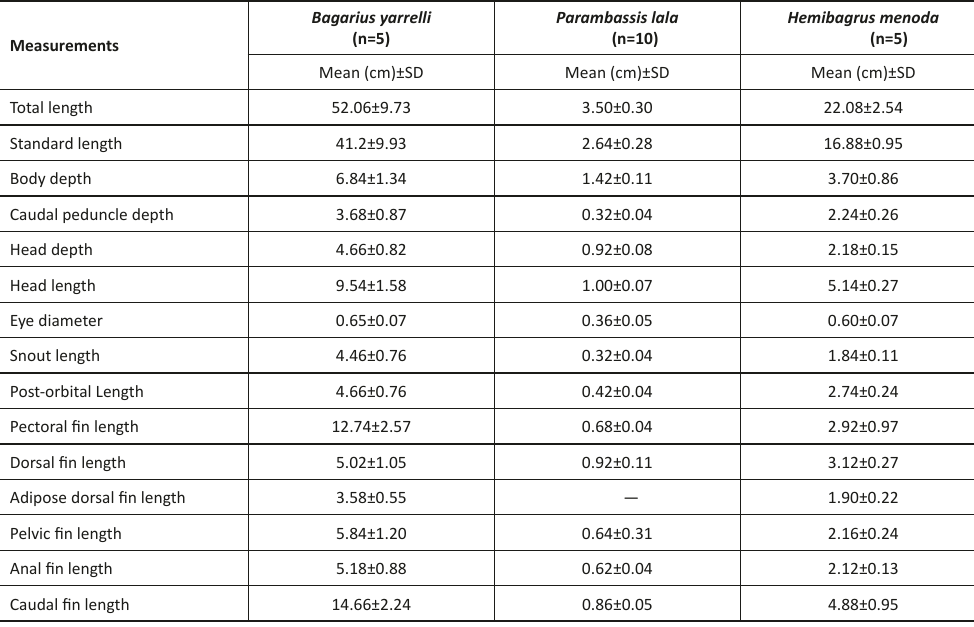
Table 1. Morphometric measurements of the three newly recorded species of